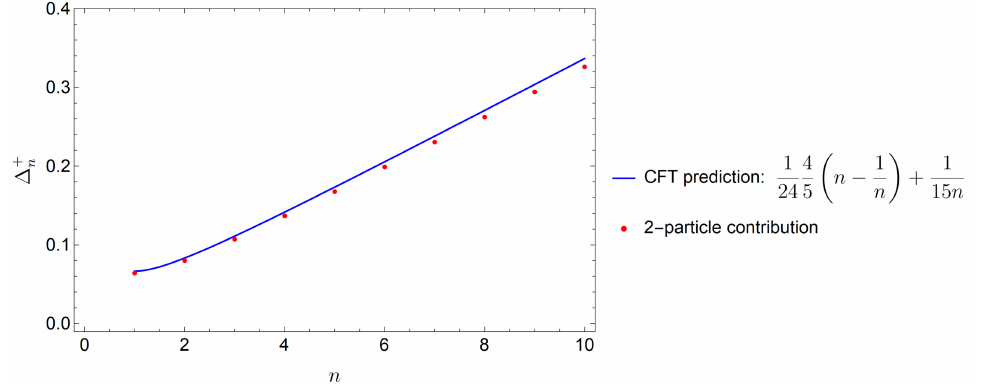
Figure 5 . Conformal dimension of the CTF T τ compared to the exact CFT formula (blue